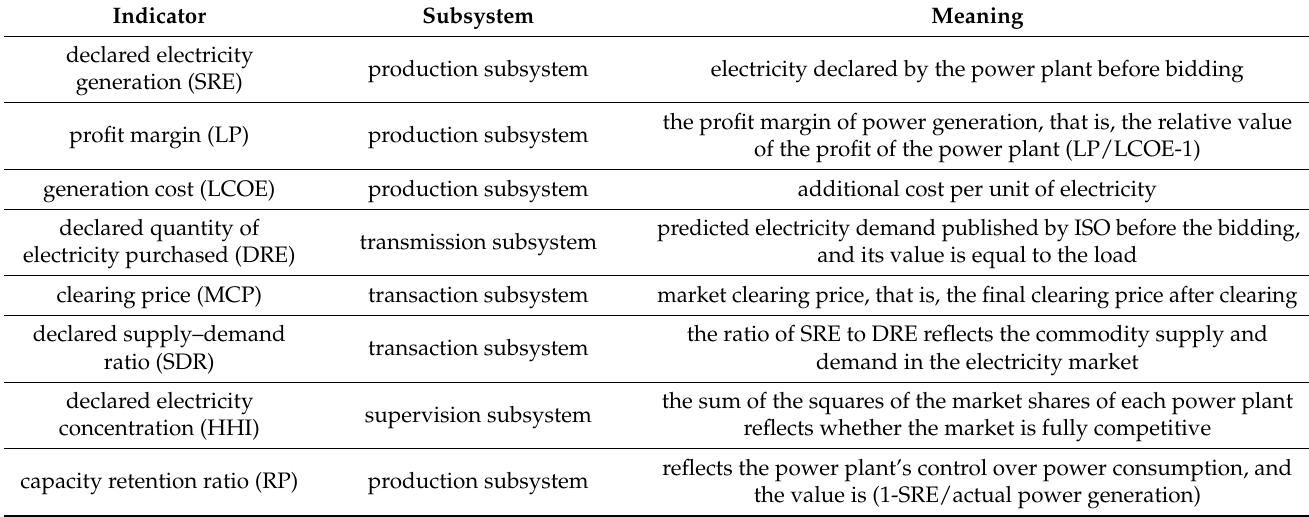
Table 1. Main indicators in SDS of the electricity